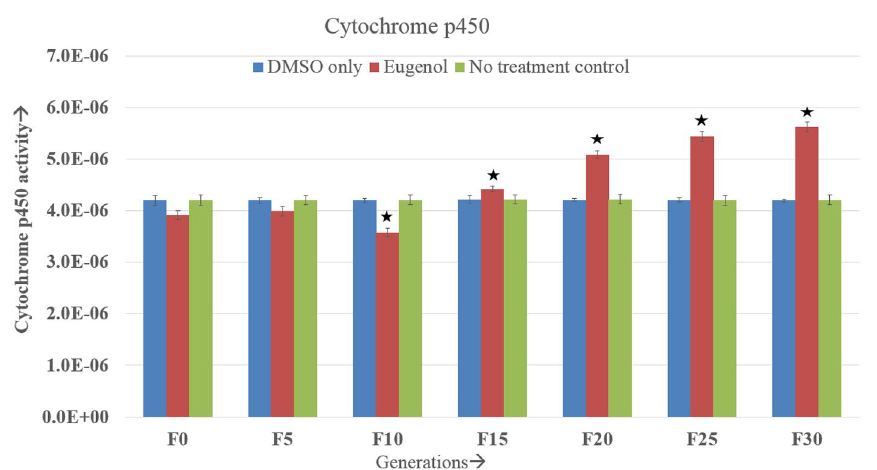
Figure 5. Cyt P450 enzyme activity (± SE) in continuously exposed (F0 to F30) A. aegypti larvae. The asterisks represents the significant difference between the experimental groups. Tukey’s post hoc test was employed